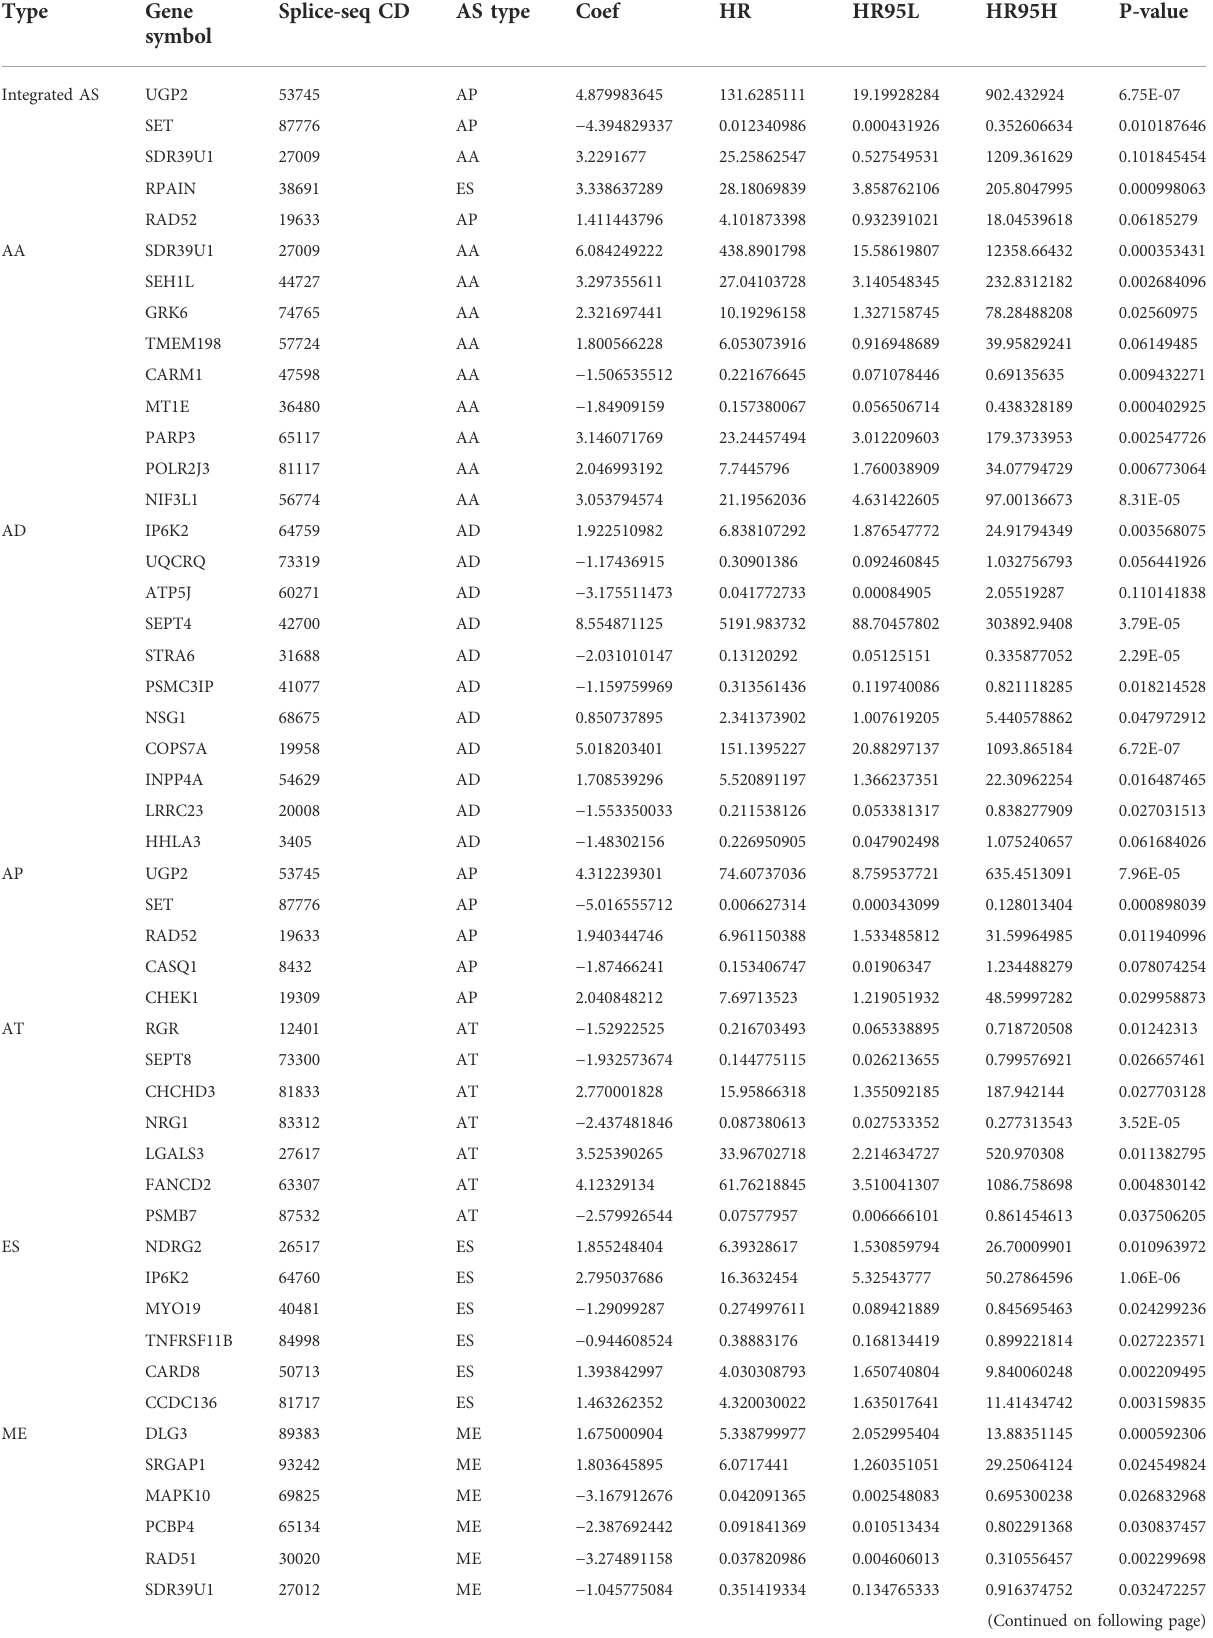
TABLE 2 Multivariate Cox analysis of prognostic N6-Methyladenosine-Related AS signatures of each AS